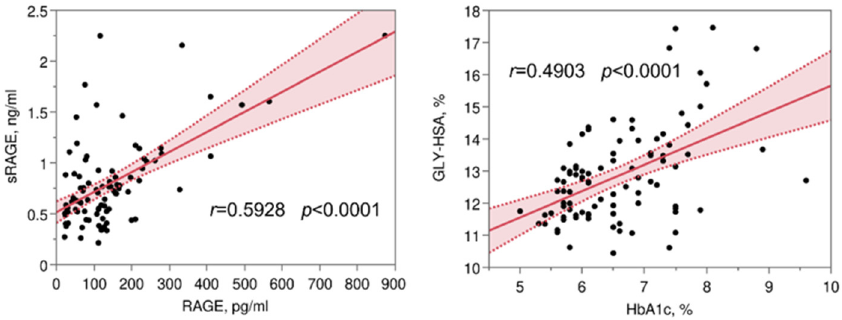
Figure 3. Scatter plot of variables presenting the most relevant correlations among those reported in Supplementary Table S2. Each plot shows a fitted linear regression line with a shaded 95% confidence interval. GLY-HSA, glycated albumin; RAGE, receptor for advanced glycation end-products; sRAGE, soluble RAGE; HbA1c, glycated hemoglobin.